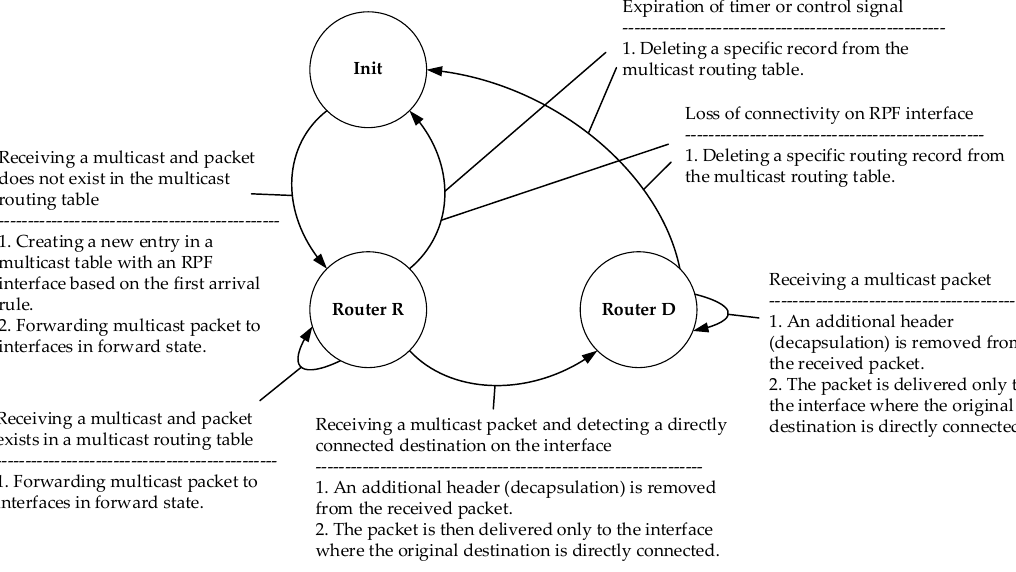
Figure 6. The M-REP state diagram for D and R routers.